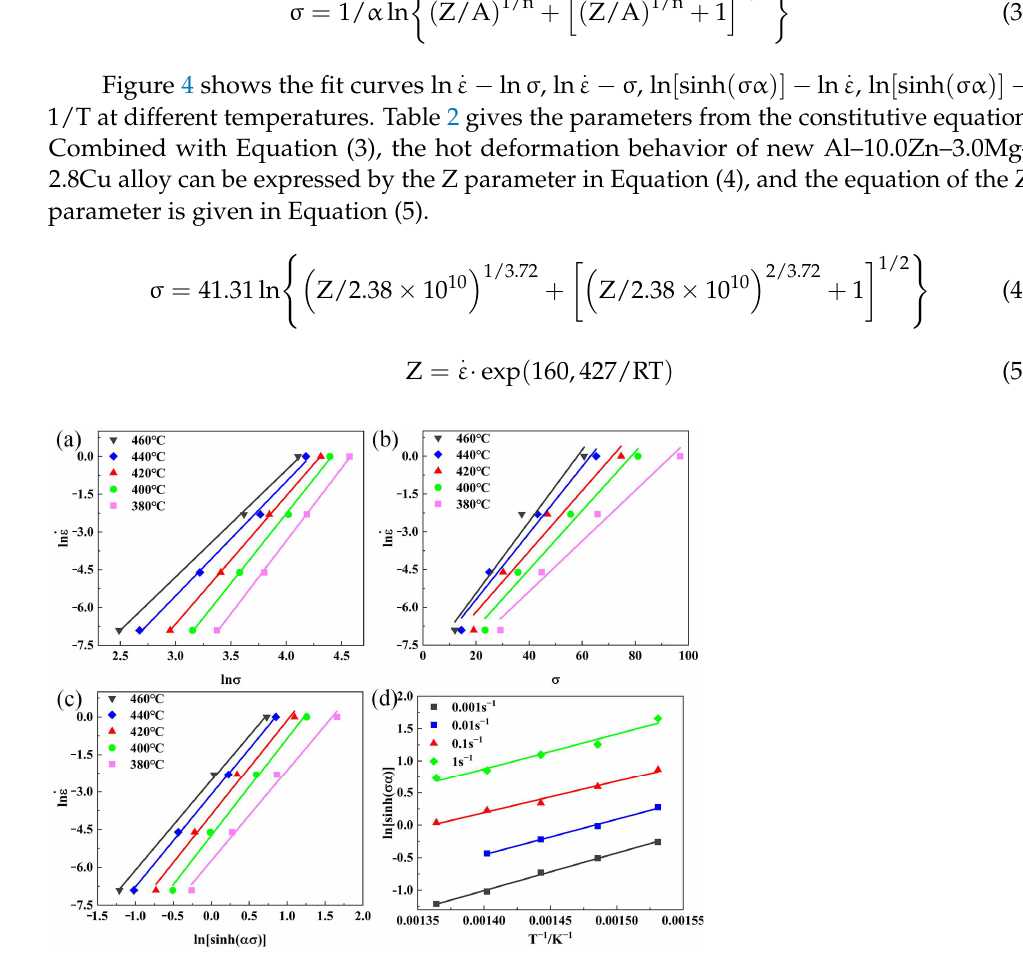
. ε − . ε − σ . ε − ln σ , ( b ) ln , ( c ) ln ln [ sinh ( ασ )] , ( d ) ln [ sinh ( σα )] − 1/T.